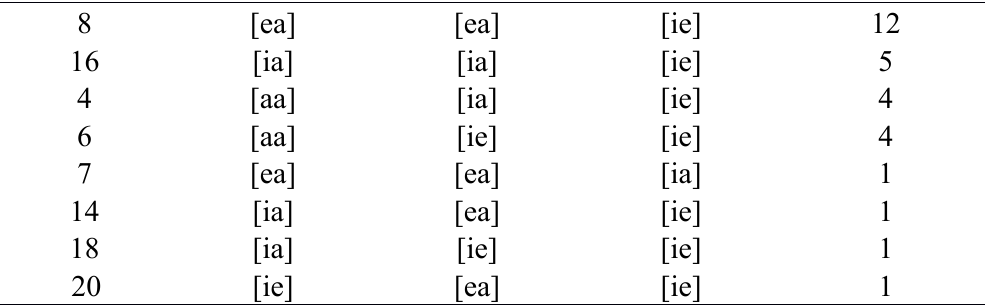
Table 1 . Logical patterns that are attested in the dataset and their observed frequencies in the Basque dialect area